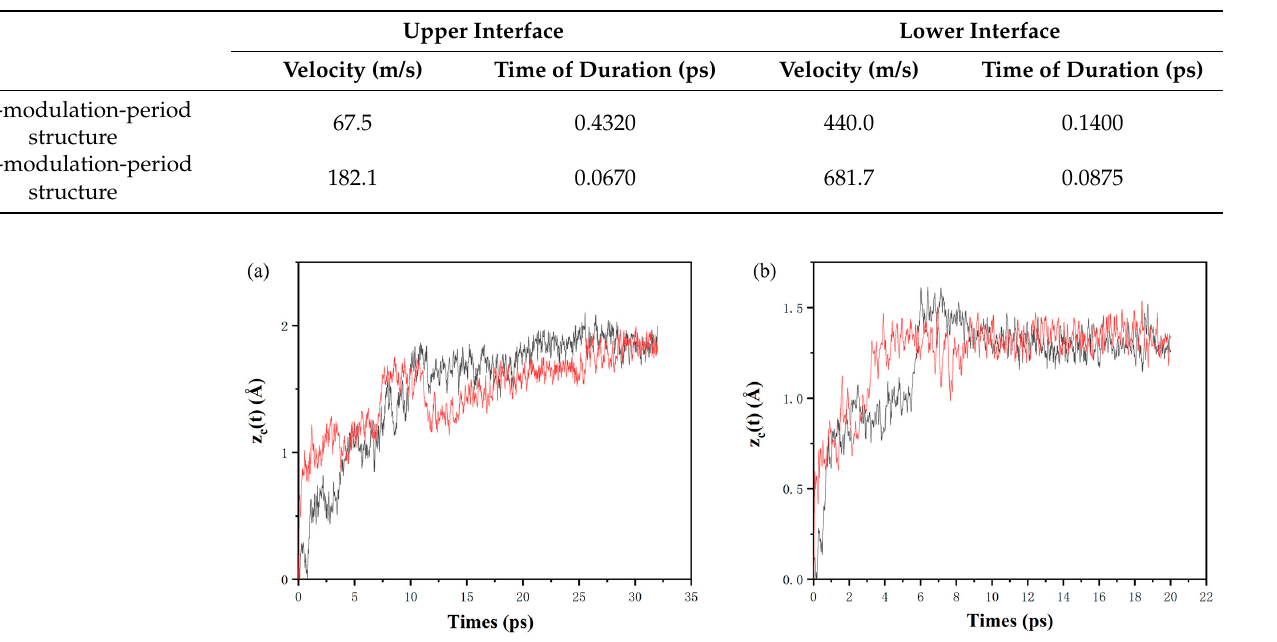
Figure 6. ( a ) Time evolution of the positions z c (t) of center oxygen atoms for the one-modulation- period nano Al /CuO energetic composite films. ( b ) Time evolution of the positions z c (t) of center oxygen atoms for the two-modulation-period nano Al/CuO energetic composite